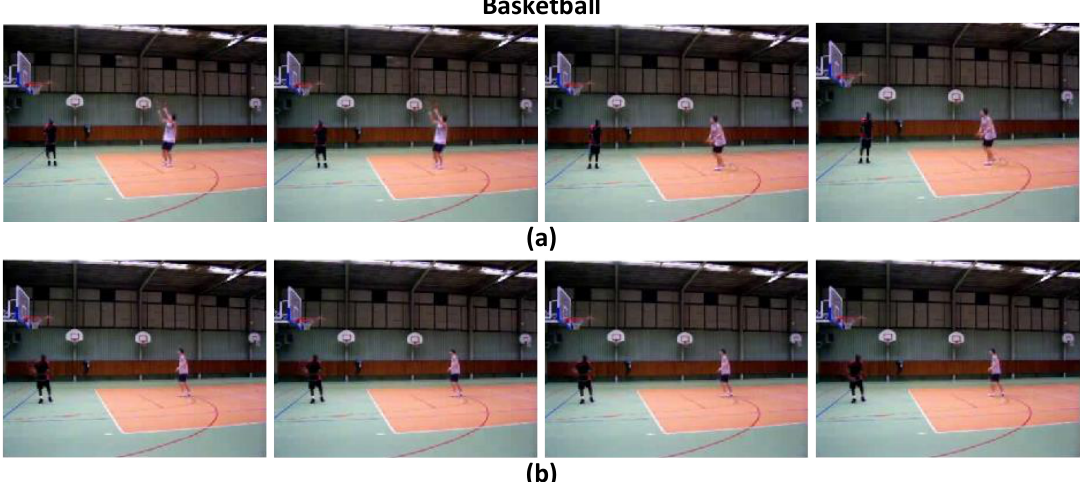
Figure 4. ( a ) The highest ranking four frames in terms of attention weights, in which the athlete is shooting jump. ( b ) The lowest ranking four frames in terms of attention weights, in which the athlete exhibits before or after the shooting.